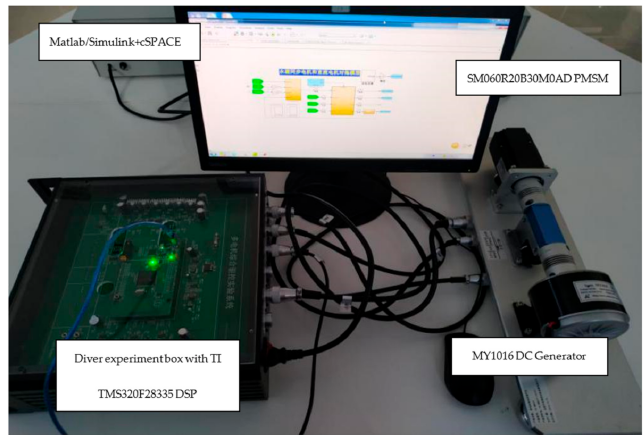
Figure 7. The PMSM experimental